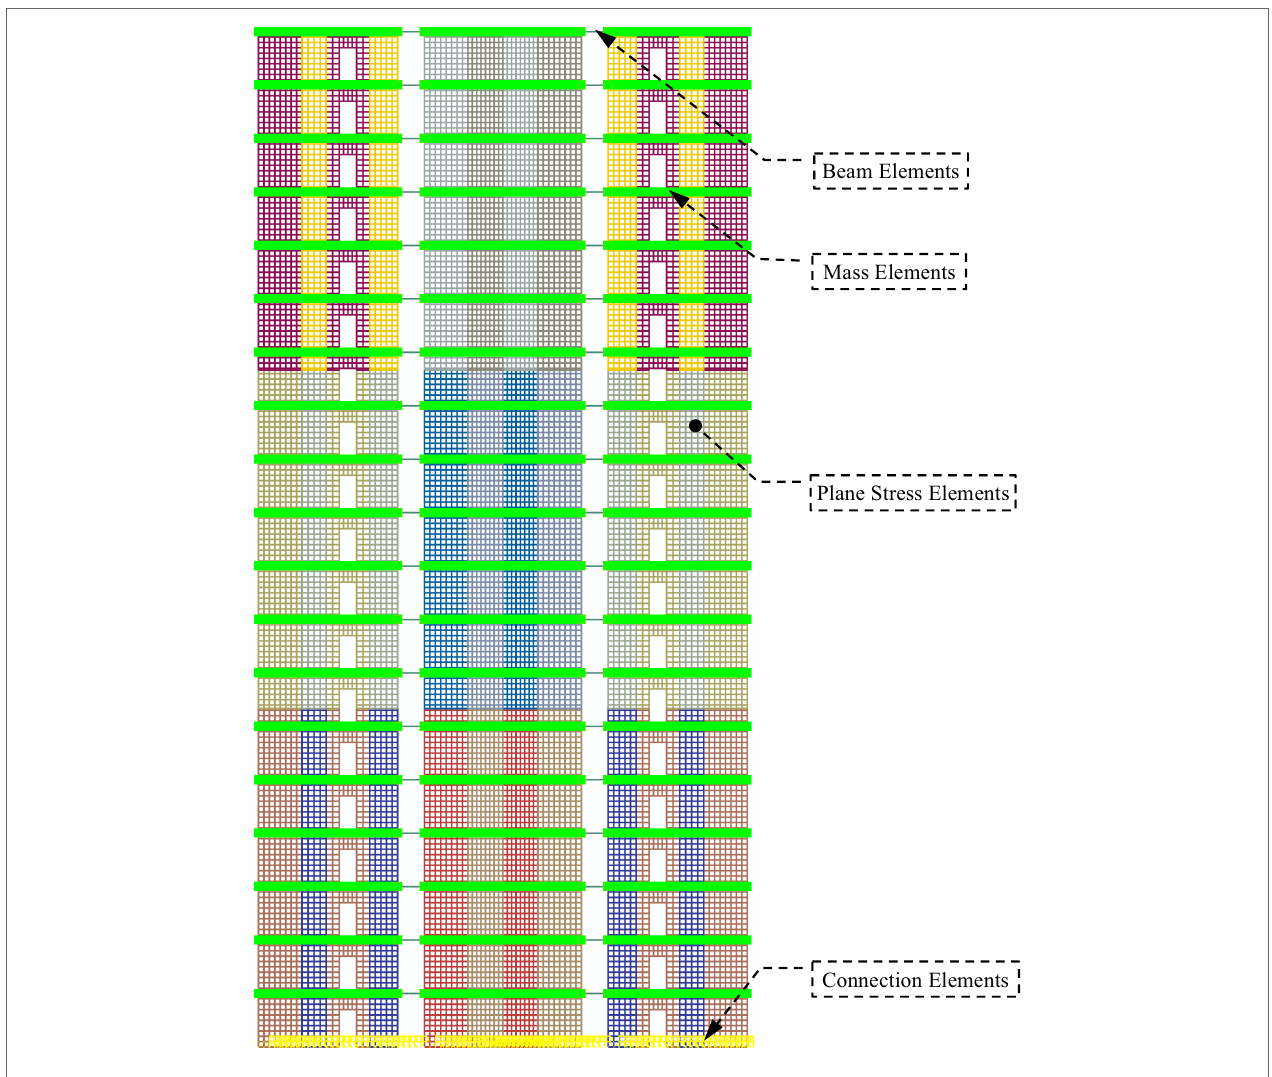
FigUre 4 | Finite element model (2D) of CHECKER